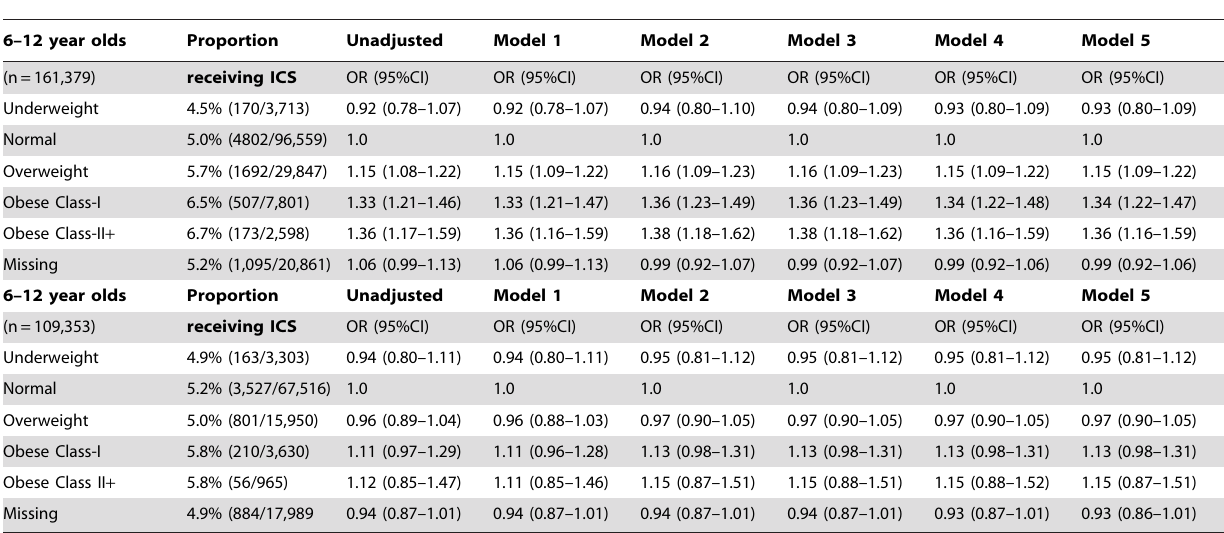
Table 2. Associations between maternal BMI and inhaled cortisone for children aged 6–16 years.